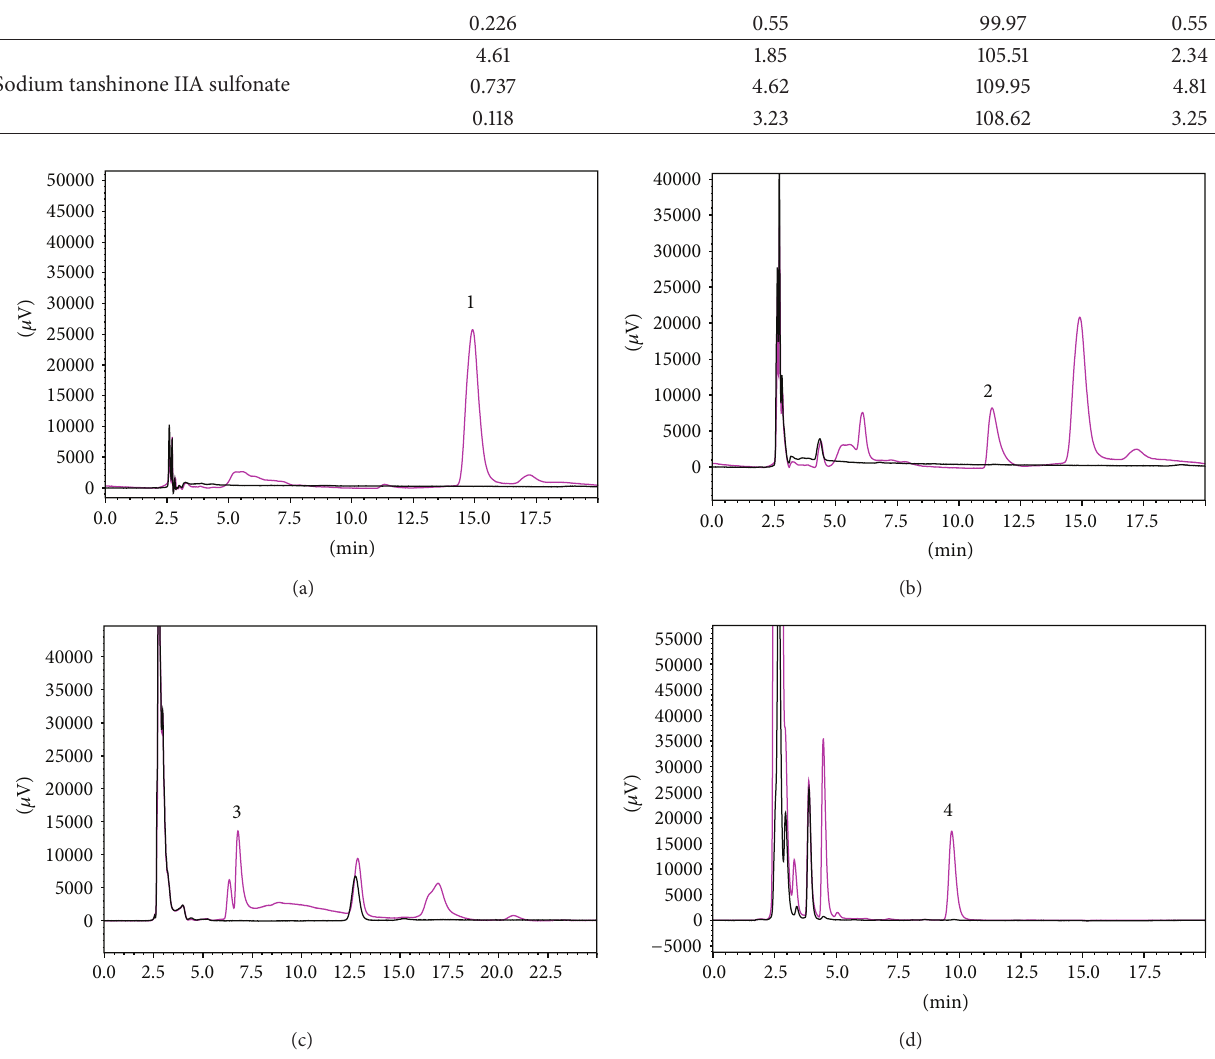
Figure 4: Chromatograms of blank plasma (black) and plasma sample at 30 minute (pink). Peaks: 1, sodium ferulate; 2, tetramethylpyrazine hydrochloride; 3, tanshinol sodium; 4, sodium tanshinone IIA sulfonate.